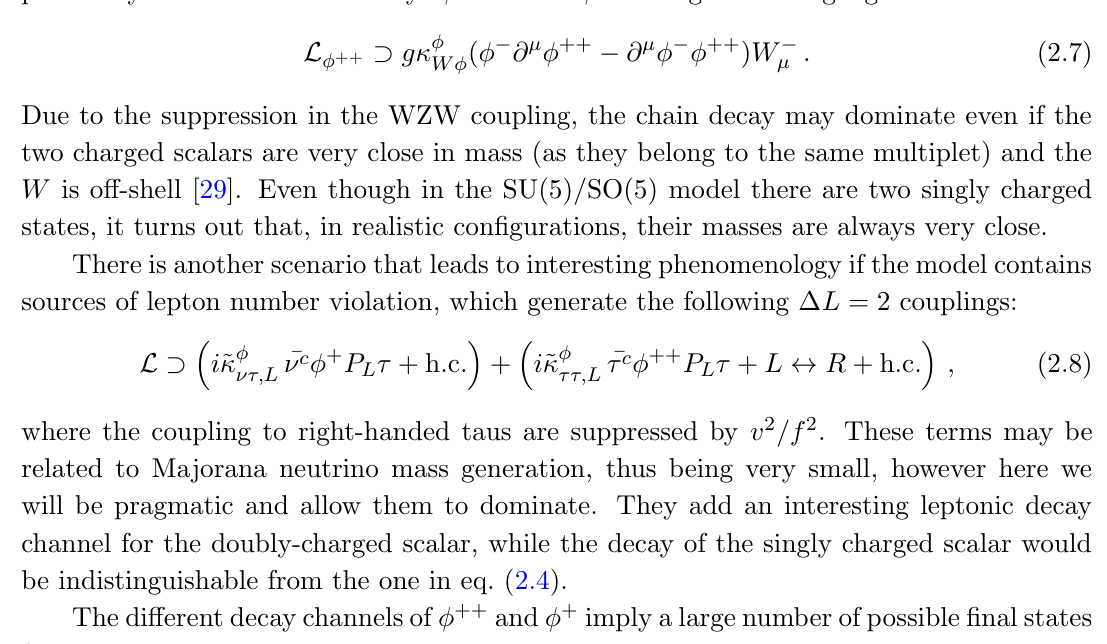
. For each channel, we indicate the relevant couplings and BSM